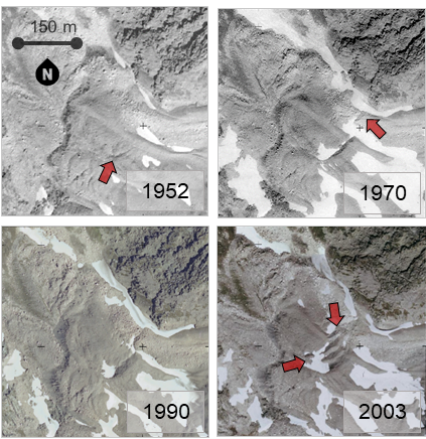
Figure 3. The evolution of the destabilization of the Pierre Brune rock glacier. The destabilization evidence, in this case a crack ob- servable since 1952, evolved to a crevasse, observable in 1970. Af- terwards, the landform was stable for 20 years as destabilization evidence did not further evolve. Between 1990 and 2003 the rock glacier experienced severe destabilization with the formation of new crevasses and a scarp at the location of the 1952